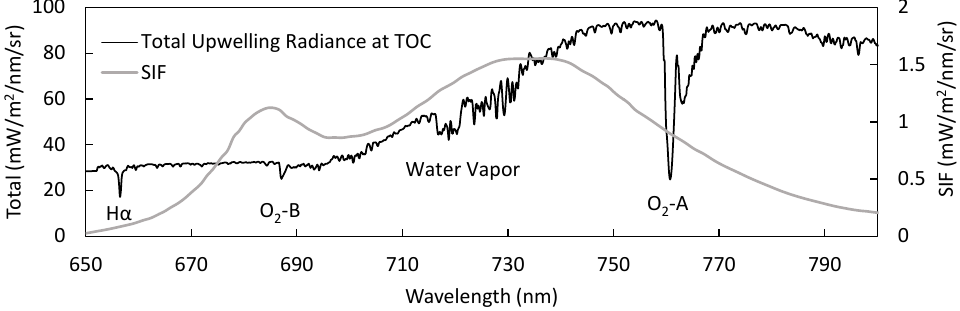
Figure 1. Total upwelling radiance and Solar-Induced chlorophyll Fluorescence (SIF) spectrum at the Top of Canopy (TOC) for the spectral range 650  800 nm with a spectral resolution (SR) of 0.3 nm and Spectral Sampling Interval (SSI) of 0.15